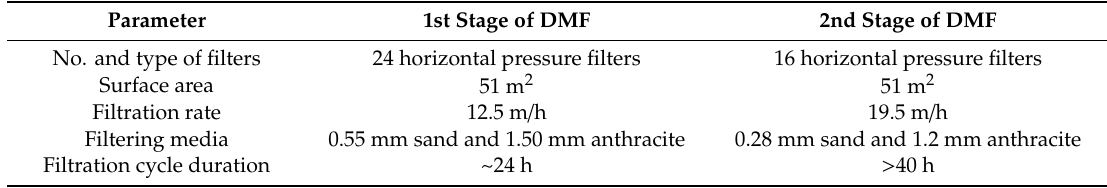
Table 2. The water properties of influent and potable water.